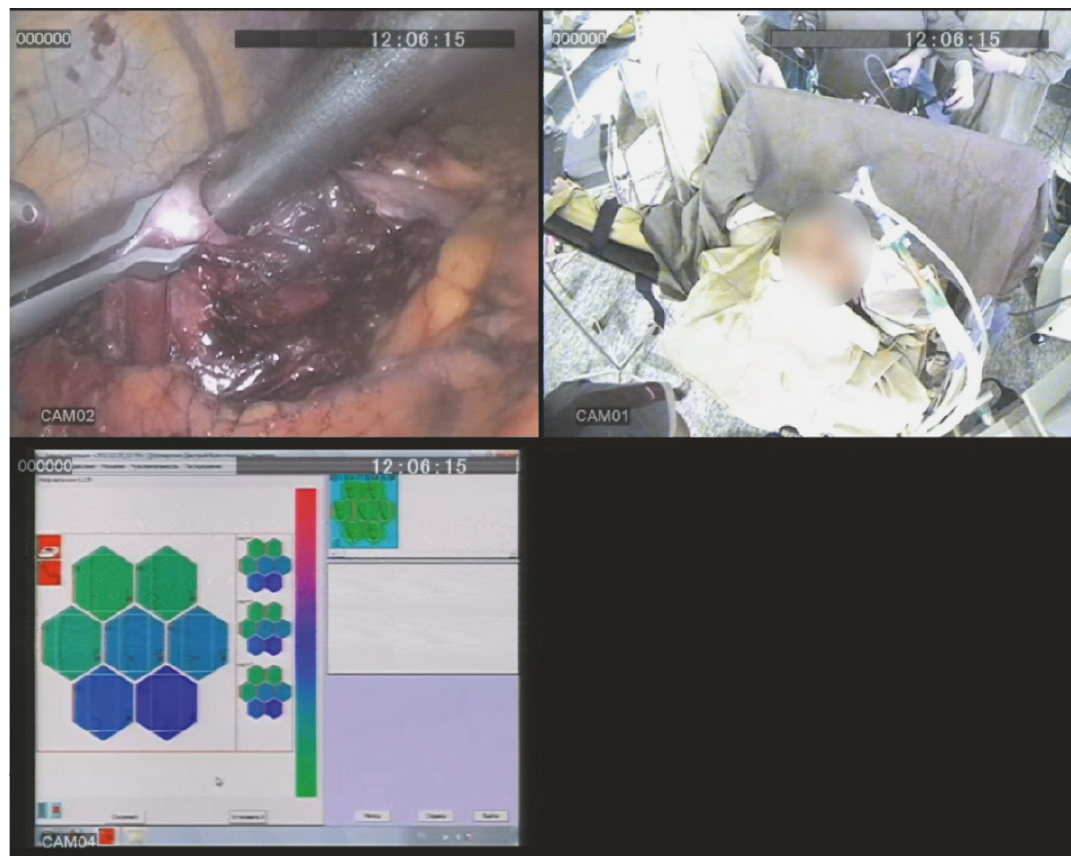
Figure 4: Instrumental mechanoreceptoric palpation of a stomach gastrointestinal stromal tumour (GIST) in laparoscopic surgery: simultaneously registered video streams from the external camera (CAM01), the laparoscopic camera (CAM02), and visualisation of tactile images